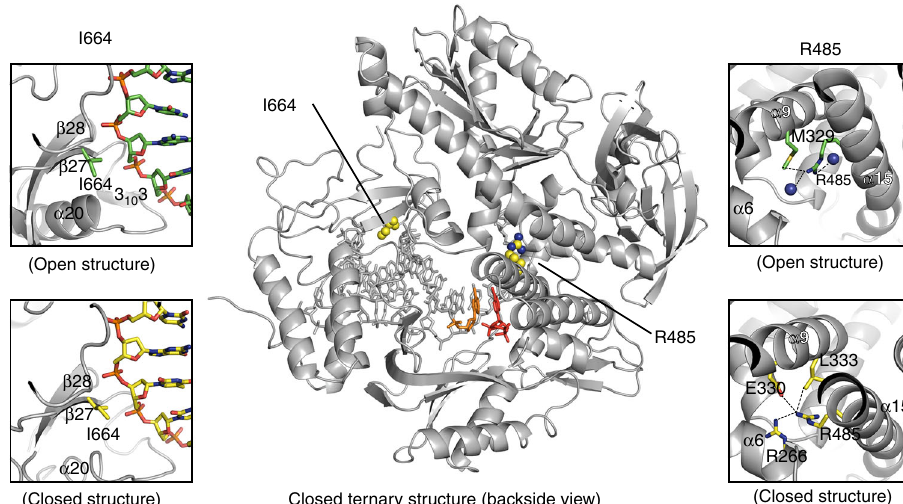
Fig. 5 TNA gain-of-function mutations. Closed ternary Kod-RI structure depicting the mutant residues Arg485 and Ile664 as space- fi ling models (center). Conformational differences observed between the open and closed forms of the ternary structure are depicted for Ile664 (left insets) and Arg485 (right insets). Residues observed in the open and closed conformations are drawn as yellow and green sticks, respectively